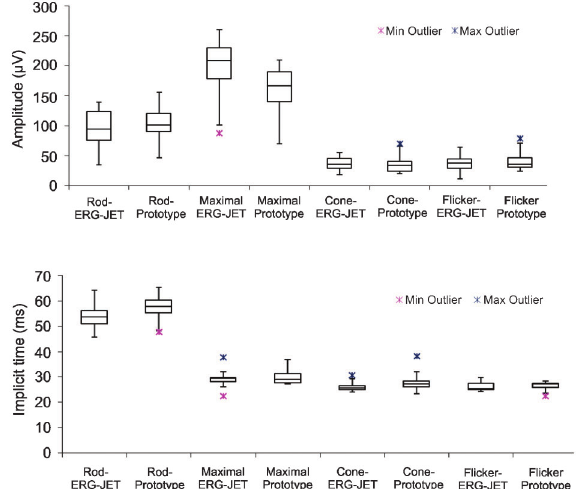
Figure 3. Box plot diagrams showing amplitude ( m V) in the upper panel and b-wave implicit time (ms) in the lower panel of a healthy Yorkshire terrier dog group for each step of the ISCEV standard protocol using the ERG-Jet lens electrode and the fiber electrode prototype. ERG = electroretinogram; ISCEV = International Society for Clinical Electrophysiology of